Question: According to the figure, is the described quantity increasing or decreasing?
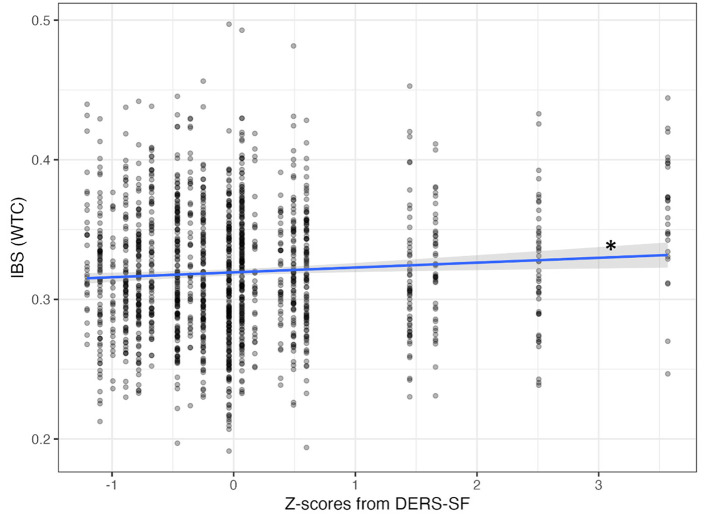
Answer: increasing